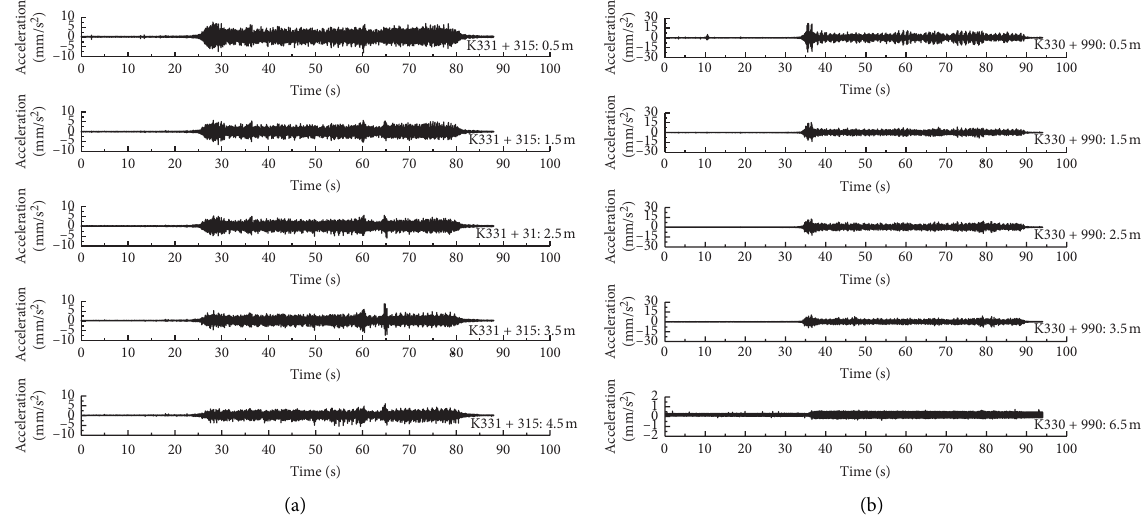
Figure 10: Time-domain diagram of vertical vibration acceleration. (a) K331+315. (b) K330 +990.